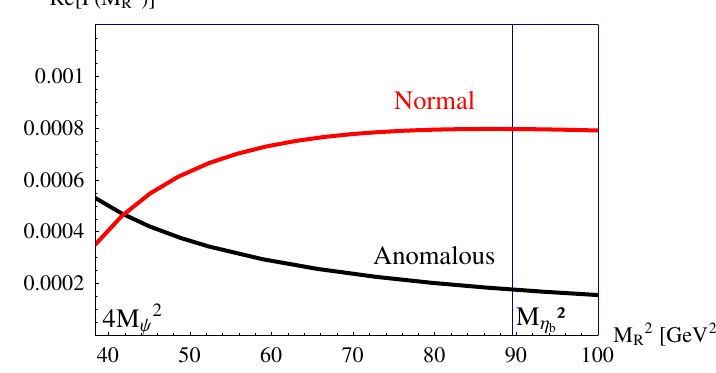
Figure 6. The real part of the normal (red) and of the anomalous (black) contributions to the amplitude F ( q 2 = M 2 , M 2 ) vs. M 2 . Here, we use the following numbers m = m D = 1.87 GeV, R R = 9.46 M = M J / ψ = 3.1 GeV, and M η b